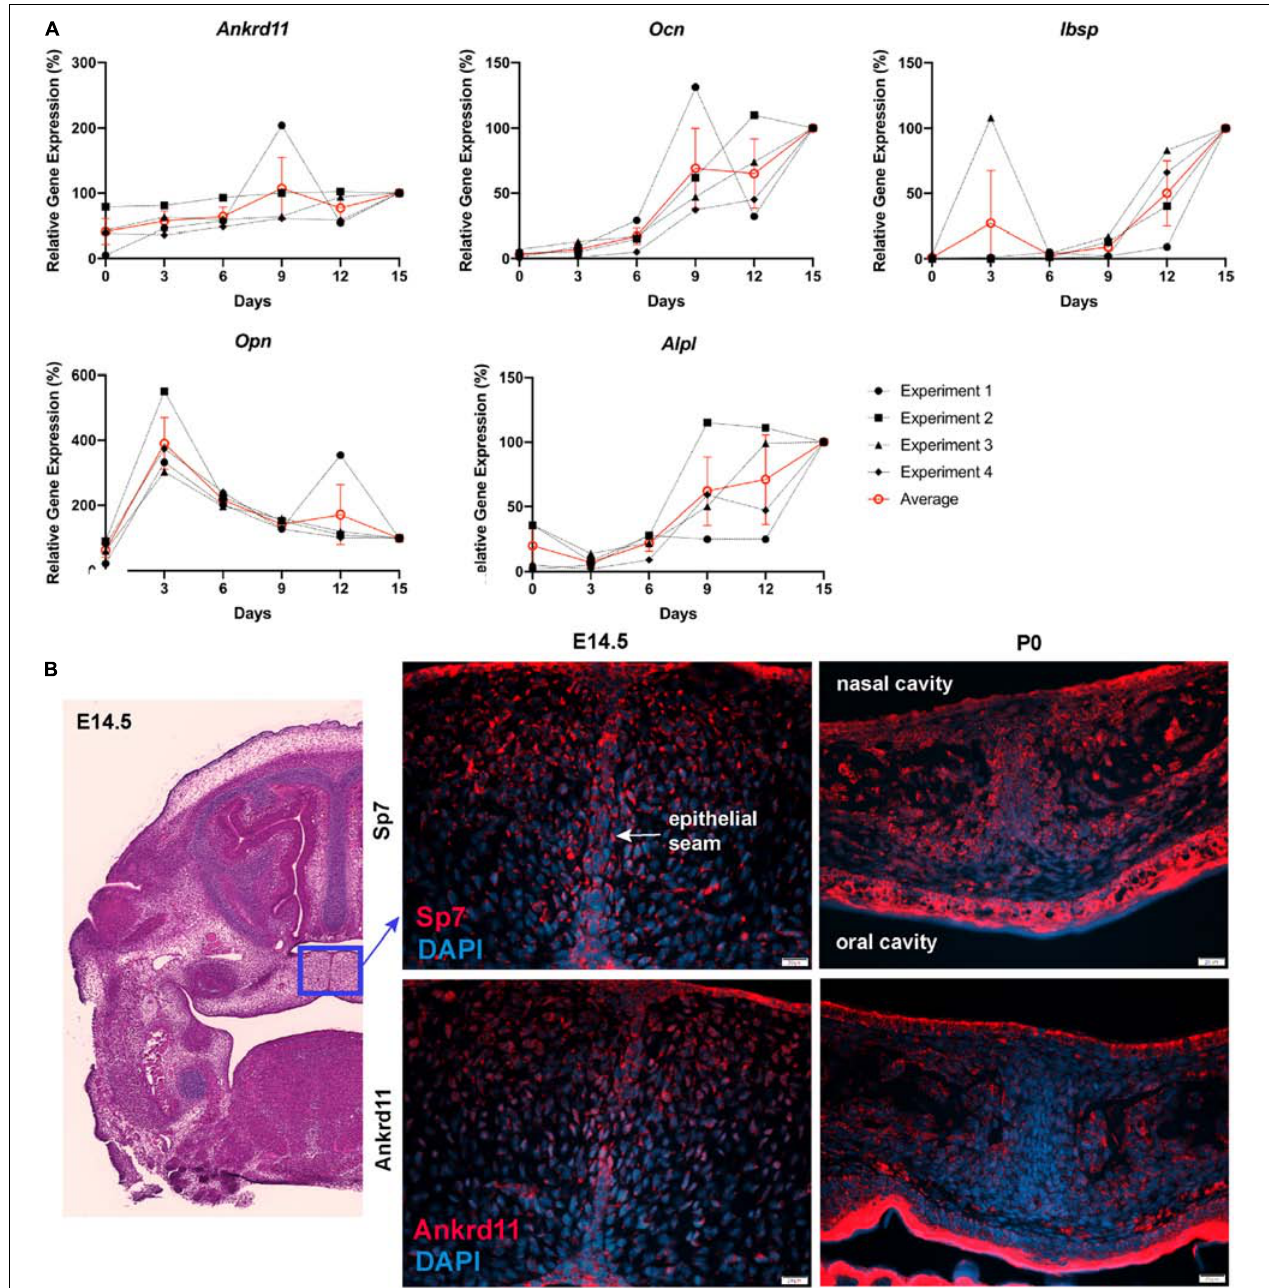
FIGURE 7 | Ankrd11 is upregulated with bone induction. (A) RT-qPCR analysis of Ankrd11 , Ocn , Ibsp, Opn, and Alp1 mRNA expression during in vitro osteogenic differentiation of P6 calvarial osteoblast precursor cells from wild-type mice. Data was normalized to 36B4 housekeeping gene. Results are relative to d15 expression from four independent biological replicates with d15 values equated to 100%. (B) Low magnification of approximate location (blue box, H&E stain) of panels showing immunostaining for Osterix (Sp7, red, top row) and Ankrd11 (red, bottom row) in E14.5 and P0 Ankrd11 ctrl mice. Images indicate similar expression domains of Sp7 and Ankrd11 at embryonic stages with expression pattern varying at birth. DAPI (blue) was used to counterstain nuclei. n = 3. D, days; E, embryonic; P,